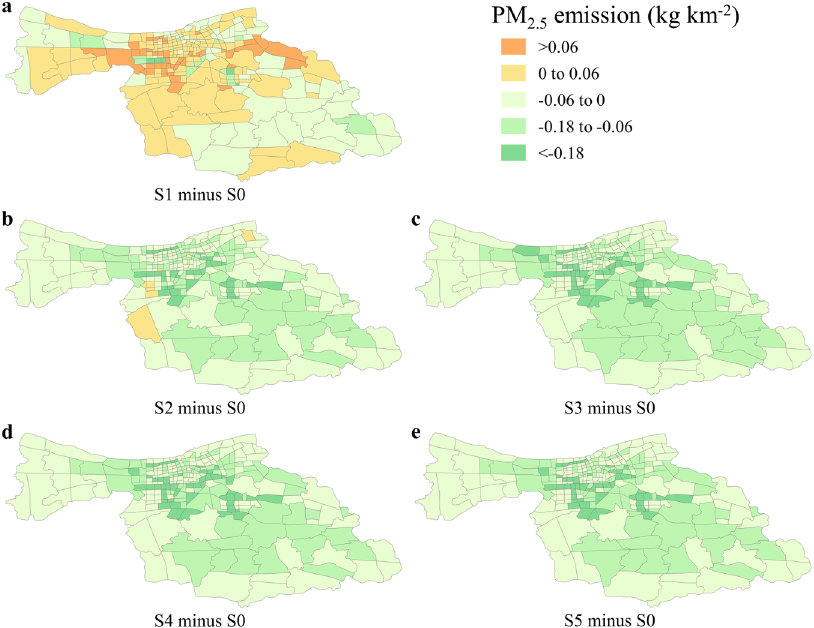
Fig. 3 The impact of SAVs on PM 2.5 emission. The spatial distribution of relative PM 2.5 emission between different SAV pricing scenarios and Scenario S0 across the study area. SAV pricing scenarios incorporate Scenario S1 ( a ), Scenario S2 ( b ), Scenario S3 ( c ), Scenario S4 ( d ), and Scenario S5 ( e ). Orange indicates increased PM 2.5 emission in SAV pricing scenarios, and green indicates reduced PM 2.5 emission in SAV pricing scenarios. Supplementary Figs. 2 – 6 presents the impact of SAVs on the emissions of CO 2 and other air pollutants. Jiangyin City, Jiangsu Province, China, is the background. This city, as a county-level city in Wuxi City, is one of six pilot smart cities under construction and was selected in this study to evaluate the impacts of